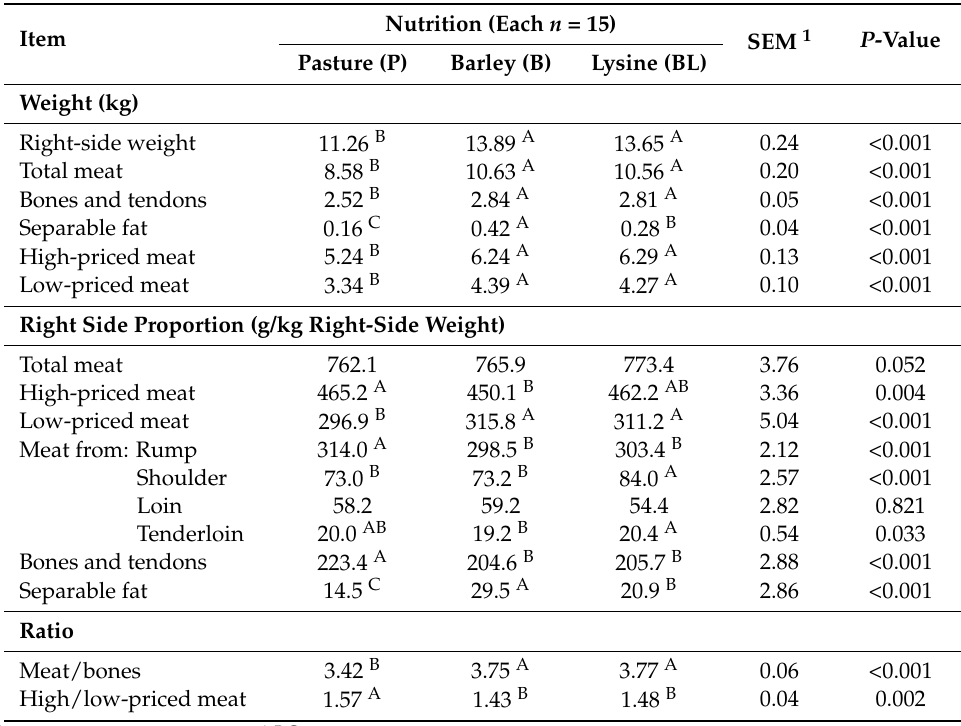
Table 3. Carcass composition of fallow deer bucks ( n =